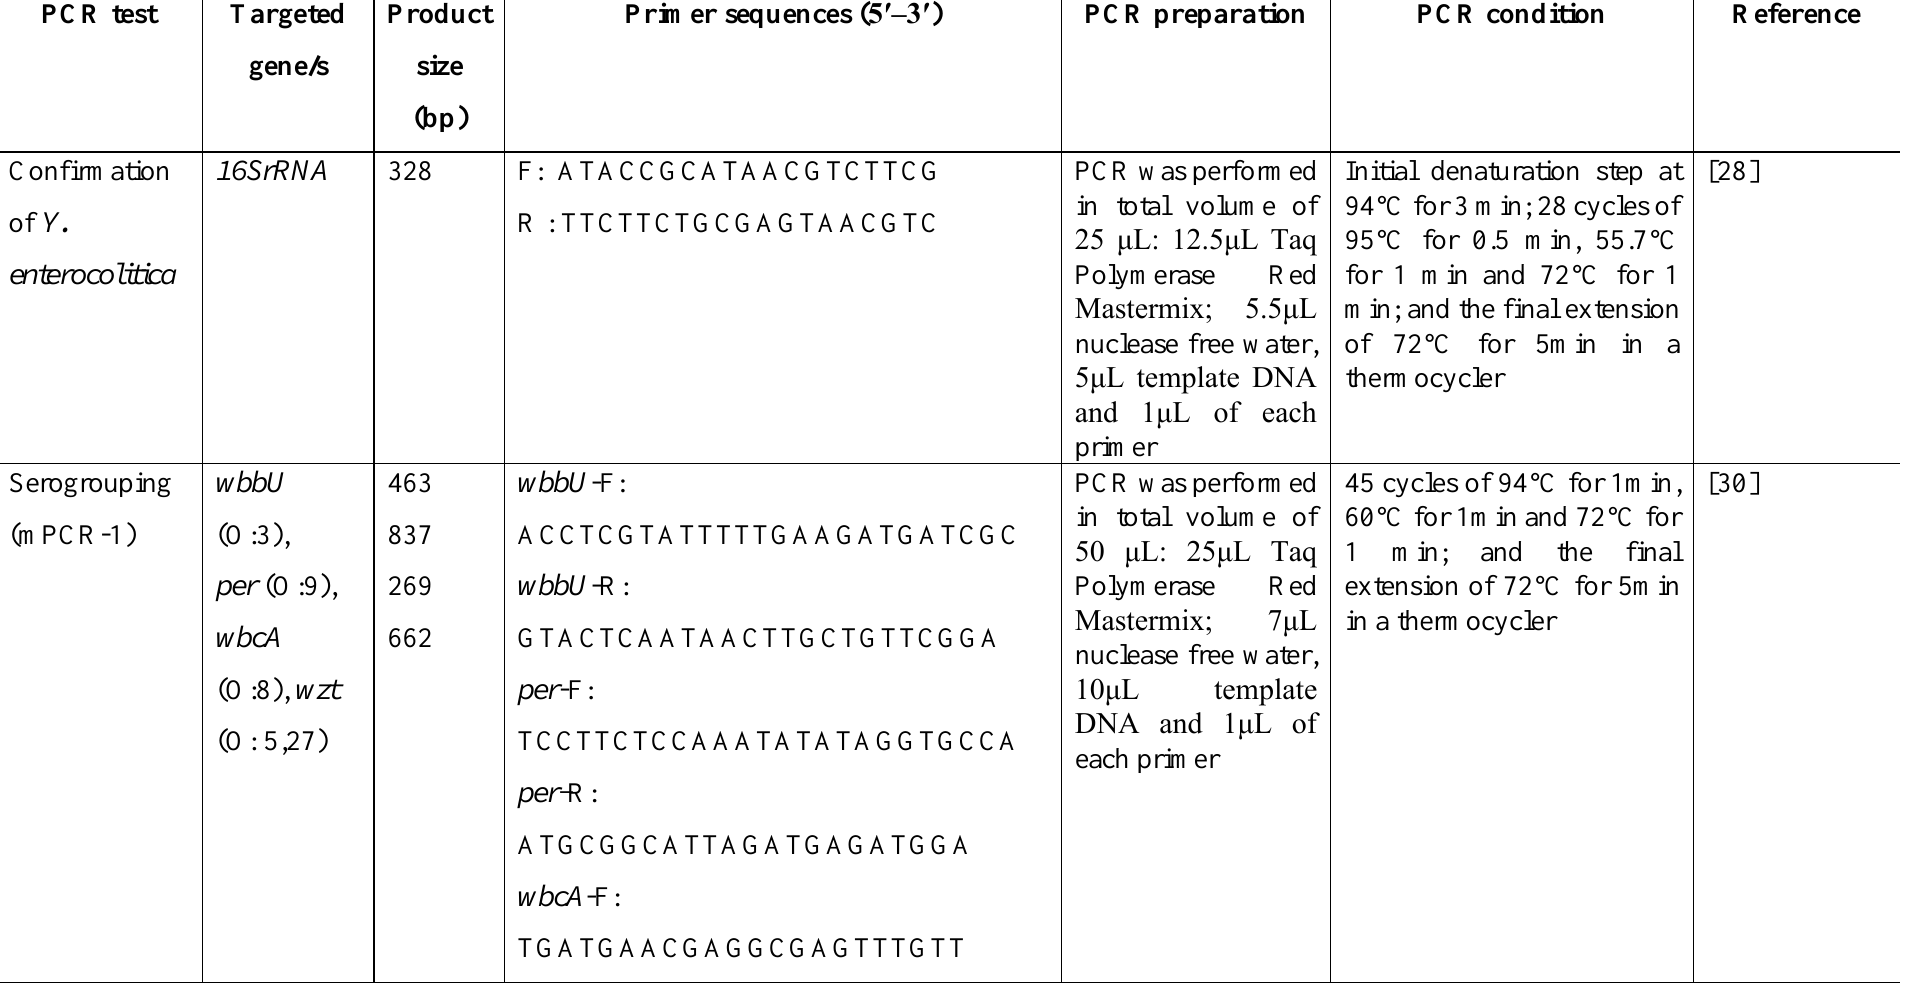
TABLE S4: Primer sequences, PCR preparation, and PCR condition used for sero-grouping and virotyping of Y. enterocolitica in the